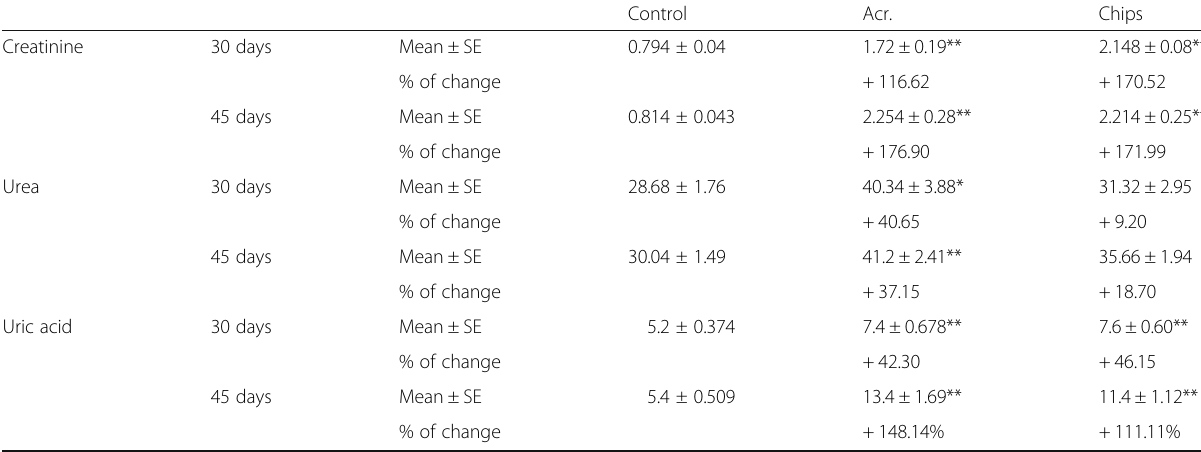
Table 3 Effect of acrylamide and chips on the plasma creatinine (mg/dl), urea (mg/dl), and uric acid (mg/dl) of mice at 30 and 45 days of administration